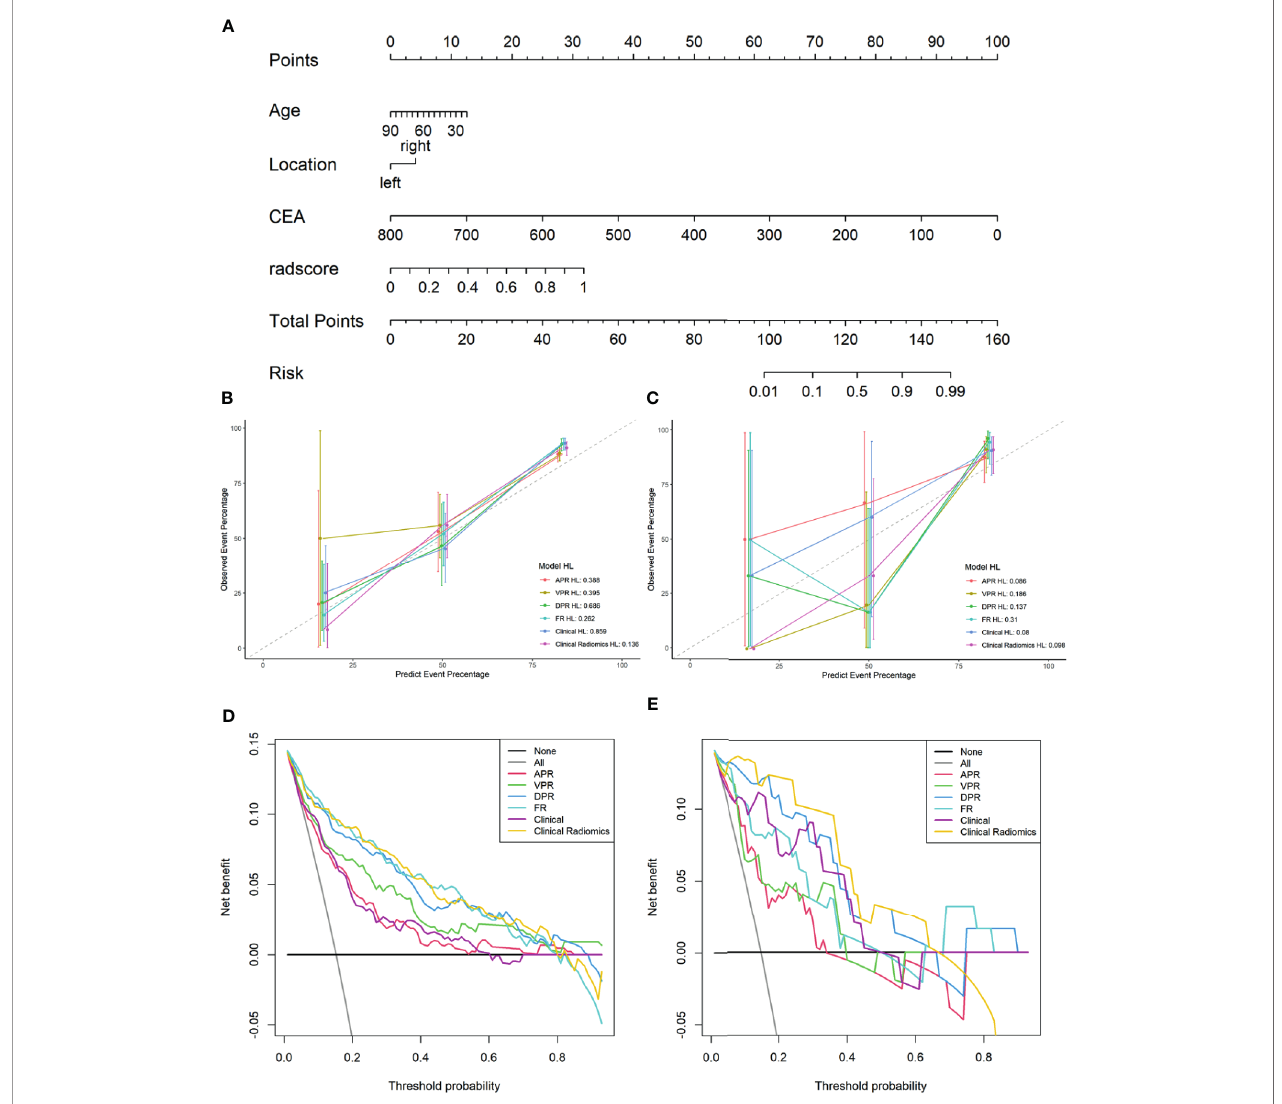
FIGURE 4 | A Clinical Radiomics nomogram for preoperative identi fi cation of microsatellite instability status in colorectal cancer patients (A) . The nomogram was constructed based on multivariate logistic regression and consisted of three clinical factors and 16 radiomics signatures. Calibration curves of the different models in training cohort (B) and validation cohort (C) ; the y-axis represents the actual microsatellite instability rate and the x-axis represents the predicted microsatellite instability risk. The diagonal dotted line indicates that the predicted outcome perfectly corresponds with the actual outcome. The solid line indicates the bias- corrected accuracy of the different models, with a closer fi t to the diagonal dotted line representing a better prediction. Decision curve analysis of the different models in training cohort (D) and validation cohort (E) ; the y-axis represents the net bene fi t, which is calculated by subtracting the expected harm (false positives) from the expected bene fi t (gaining true positives) and subtracting expected harm (deleting false positives). The higher curve at any given threshold probability is the optimal prediction to maximize net bene fi t. The solid colored lines represent the different models. The solid gray line represents the assumption that all patients had microsatellite instability. The solid black line represents the assumption that no patients had microsatellite instability. APR, radiomics model of arterial phase; DPR, radiomics model of delayed phase; VPR, radiomics model of venous phase; FR, radiomics model of fusion of arterial phase, delayed phase and venous phase features; Clinical Radiomics, fusion of clinical risk factors and radiomics features of delayed phase; HL, Hosmer-Lemeshow